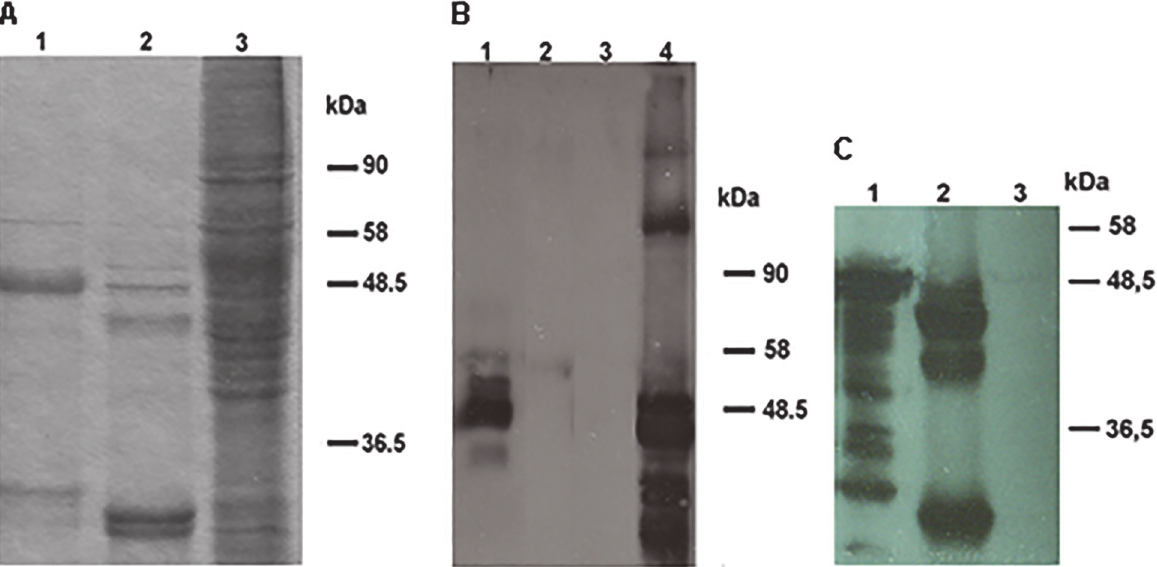
Fig 1. SDS-PAGE-Coomassie staining and Western Blot of HPV18L1 – 45RG1 VLP. Purified and dialyzed 18L1 – 45RG1 VLP (lane 1), HPV18 wt L1 VLP (lane 2) or crude Sf9 lysate (lane 3) were separated by SDS-PAGE followed by Coomassie staining (A). The L1-RG1 fusion protein migrated at a molecular weight of about 50kDa, slightly slower than wt HPV18 L1, for which smaller degradation products are also visible. Insertion of the RG1 peptide into the L1 protein and its antigenicity were verified by Western Blot using an anti-HPV16 L2 aa 11 – 200 serum (B), or Camvir-1 reacting to HPV18 L1 (C). For both Western Blots, HPV18L1 – 45RG1 fusion proteins show a molecular weight of about 50kDa (Fig. 1B lane 1; Fig. 1C lane 1), with smaller bands representing proteolytic degradation products. As controls HPV18 wt L1 VLP (Fig. 1B lane 2; 1C lane 2), HPV16L1L2 VLP (Fig. 1B lane 4) and Sf9 cells only (Fig. 1B lane 3; Fig. 1C lane 3) were